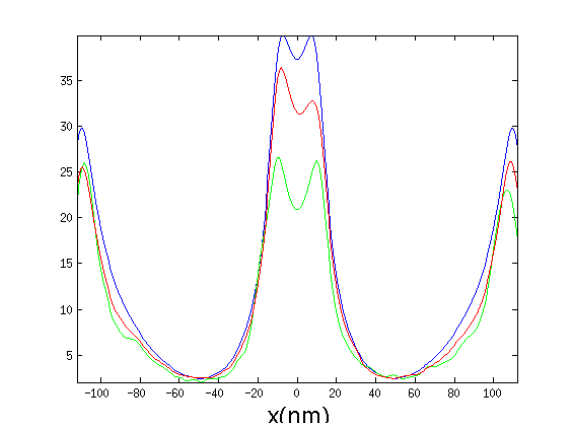
2 at 6 nm above E Figure 11: Intensity of the electric field | | the nanoantenna( — : biosensor with smooth surface, — : biosensor with rms roughness 0.82 nm and — : biosen- sor with rms roughness 1.41 nm; the gap between the two 10 to x = 10 nanorods is from x = −